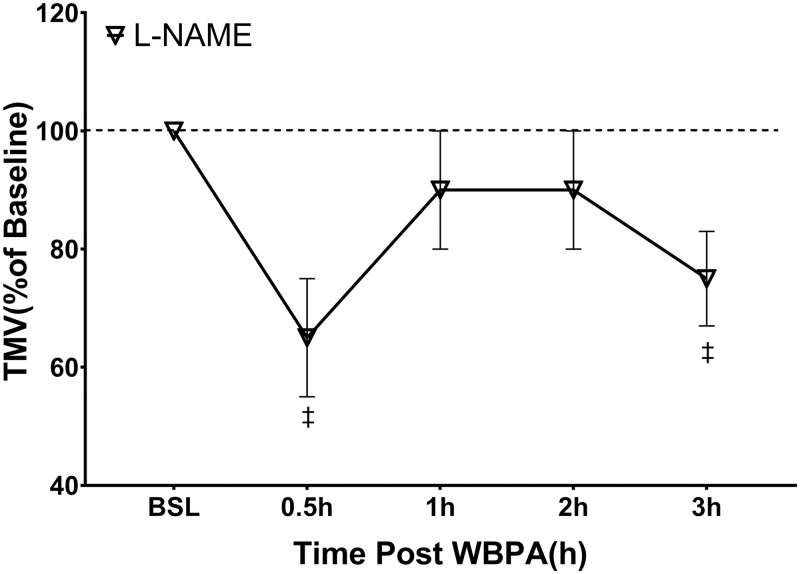
Change in Tracheal Mucous Velocity Due to NO Inhibition.Changes in TMV after the administration of L-NAME, 25 mg/kg intravenously (n = 5). Significant difference (‡p<0.05) was present between baseline vs. 0.5 and 3 hours after administration. Although the 1h and 2h mean values were below the initial starting TMV, these values did not differ statistically from the baseline values. Values are mean ± SE (ANOVA).